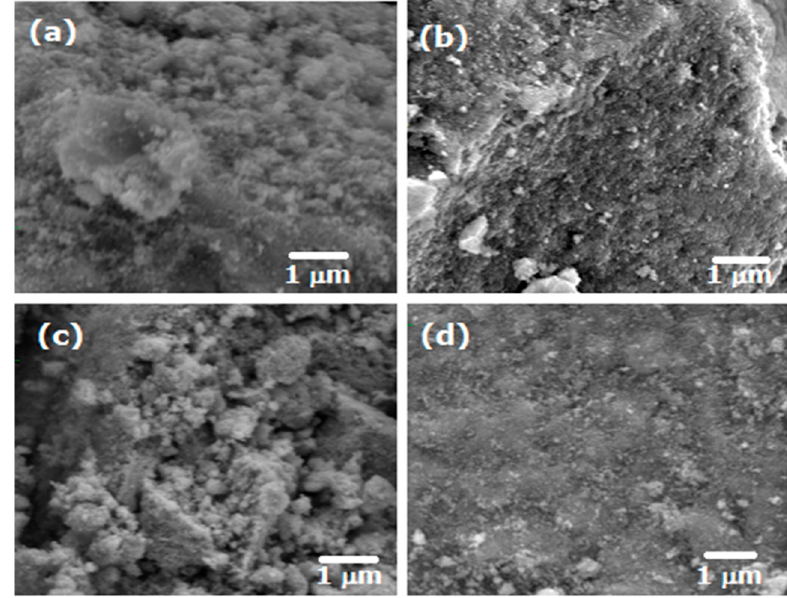
Figure 2. SEMimagesof( a )TiO 2 ,( b )Fe 3 O 4 ,( c )C-dopedTiO 2 ,and( d )C-dopedTiO 2 / Fe 3 O 4